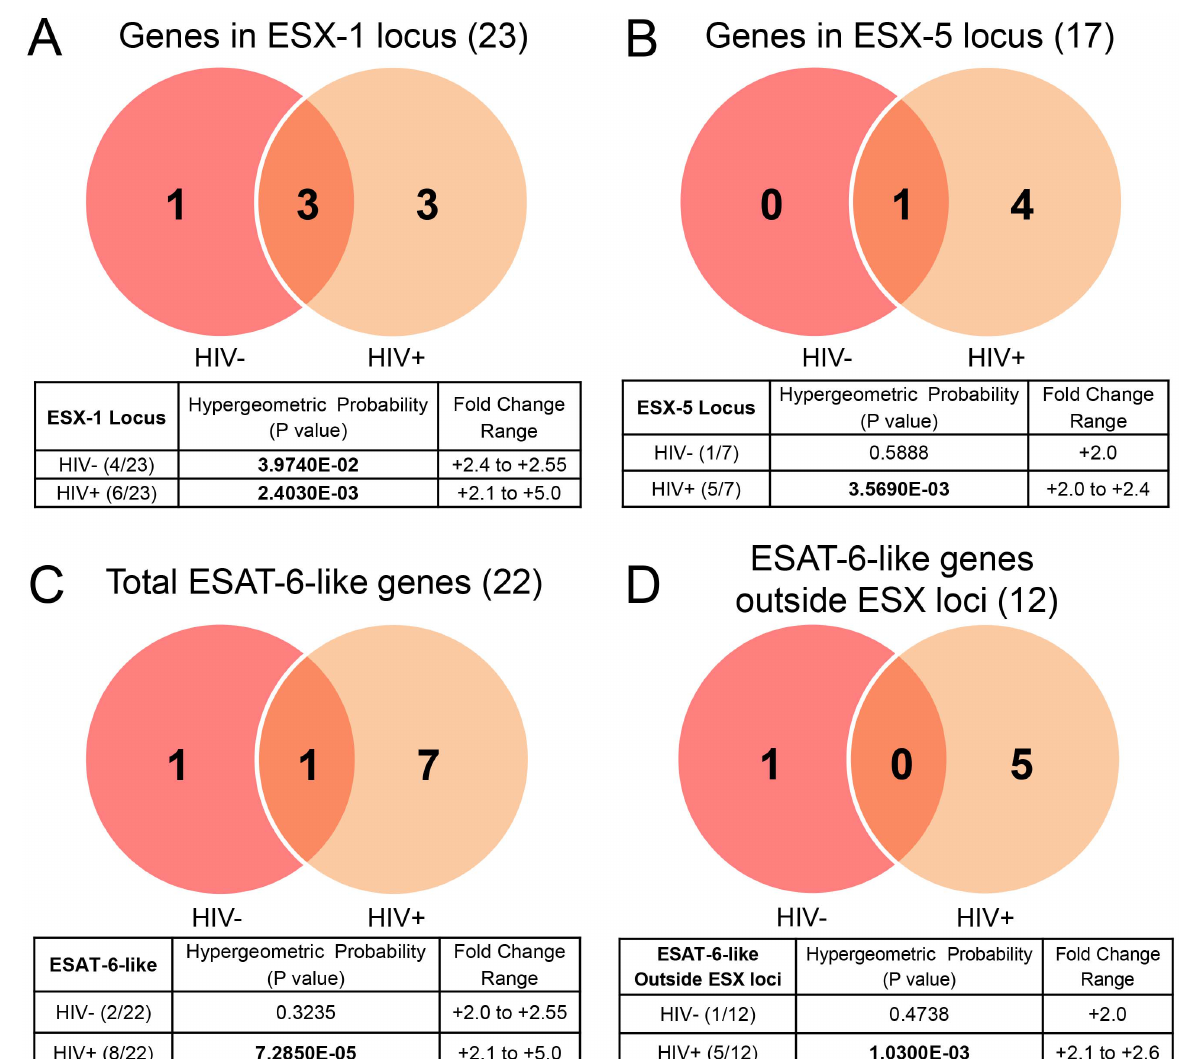
Figure 6. Upregulation of ESX loci and esat-6 -like genes. (A) Genes upregulated within ESX-1 locus. (B) Genes upregulated within ESX-5 locus. (C) Total genes encoding ESAT-6-like proteins upregulated in the M. tb genome. (D) Genes encoding ESAT-6-like proteins which are upregulated and located outside of ESX loci. Venn diagrams indicate numbers of genes upregulated in blood from HIV- and/or HIV + donors. Genes that are upregulated in both environments are in the overlap. Numbers in parentheses next to headings indicate the total number of genes in the designated category encoded in the M. tb genome. Tables below include the Hypergeometric Probability P-values from Fisher’s Exact testing of differentially expressed genes represented in each category and each blood environment (HIV- or HIV + ) (significant P-values in bold), as well as the ranges of expression fold change. Note: Genes located within ESX-2, ESX-3, and ESX-4 loci were not differentially expressed in blood from either HIV- or HIV +